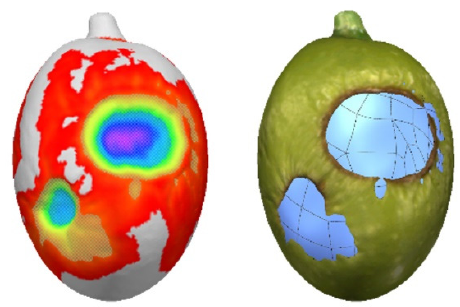
Figure 11. Diseased volumes.